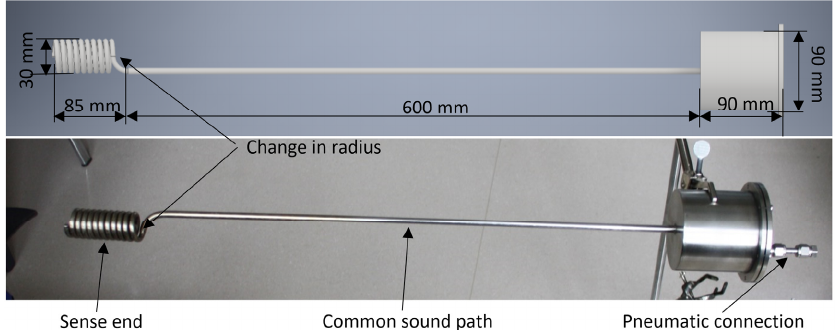
Figure 6. CAD model and photo of the PAT housing.